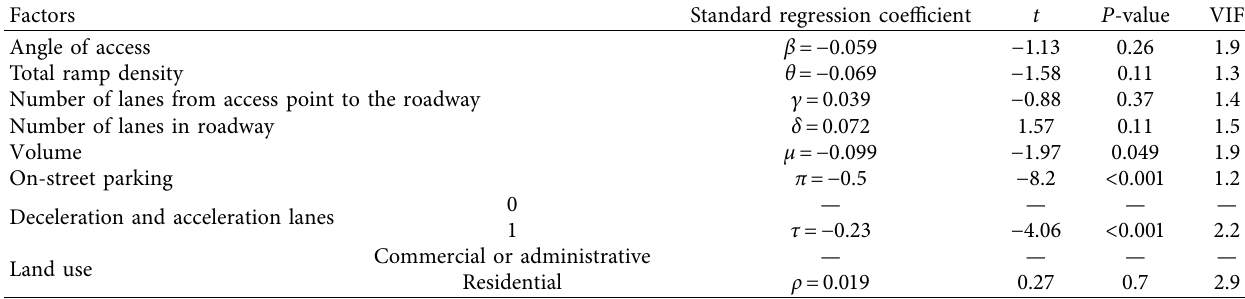
Table 4: Results of the final regression model.